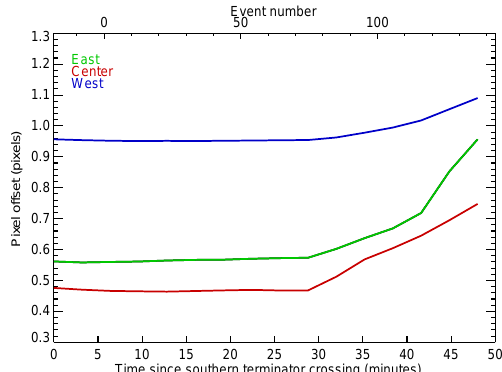
Figure 7. Slit edge results for the three slits (green: east slit; red: center slit; blue: west slit) plotted against time since southern ter- minator crossing. A 1-pixel shift corresponds to a 965m TH shift. The offsets are stable from the southern terminator to the midlati- tude Northern Hemisphere, where the exposure to the sun increases thermal effects. The event number, which is an index of LP mea- surements through each orbit, is shown at the